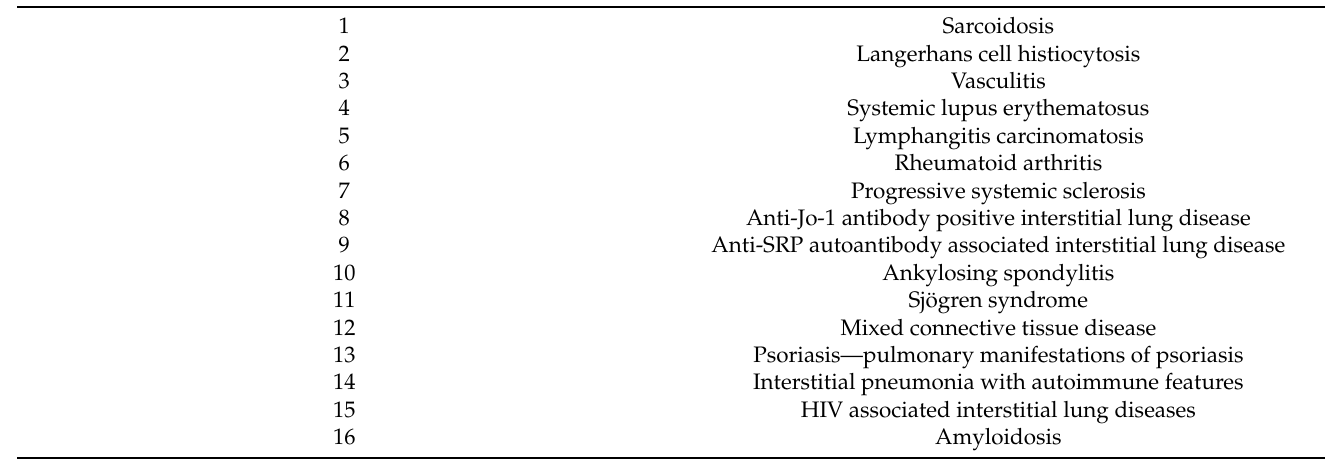
Table 1. List of well-known autoimmune